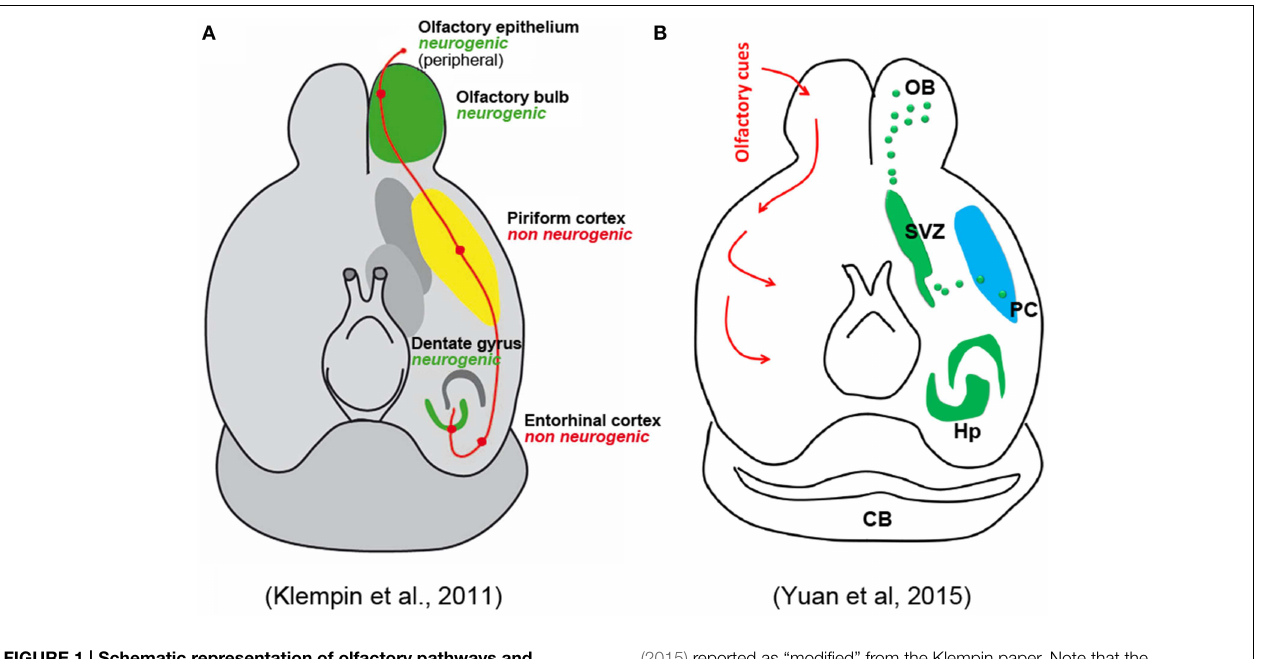
(2015) reported as “modified” from the Klempin paper. Note that the non-neurogenic piriform cortex in (A) has became neurogenic in (B) with newlyborn cells coming from the SVZ through a caudal migratory